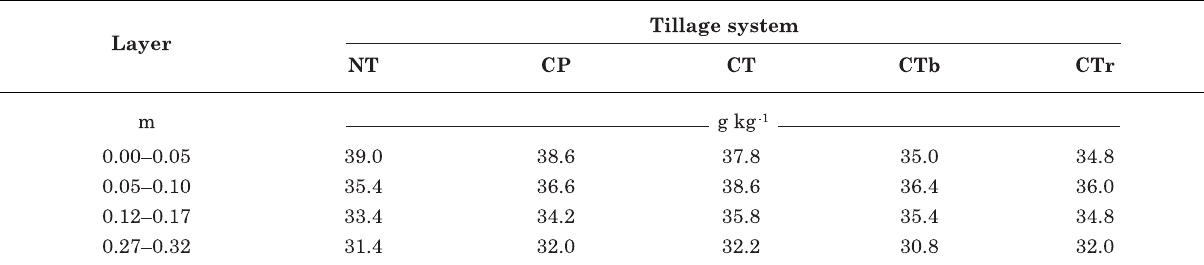
Table 6. Organic matter content in four layers after nine years under five tillage systems (averaged across nutrient